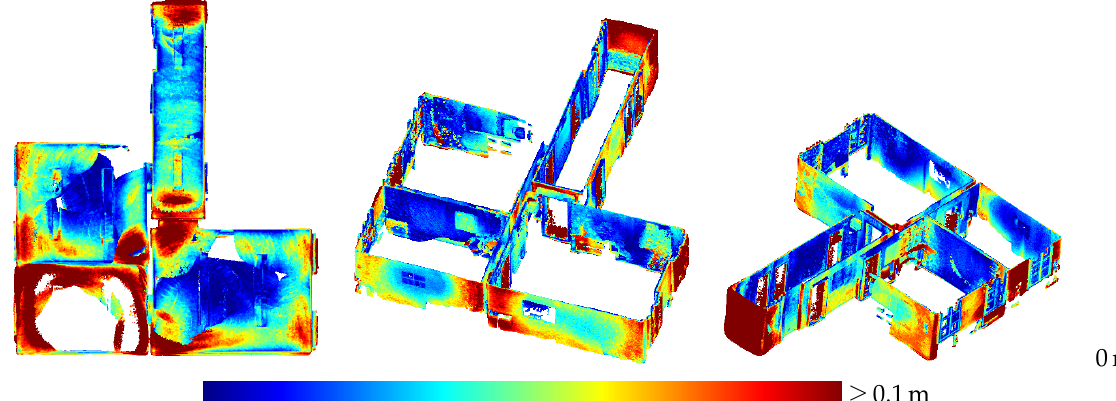
Figure 20. Accuracy of the HoloLens point cloud evaluated against the TLS ground truth. The registration was done with fixed scale. The mean distance to the ground truth amounts to 4.0cm.